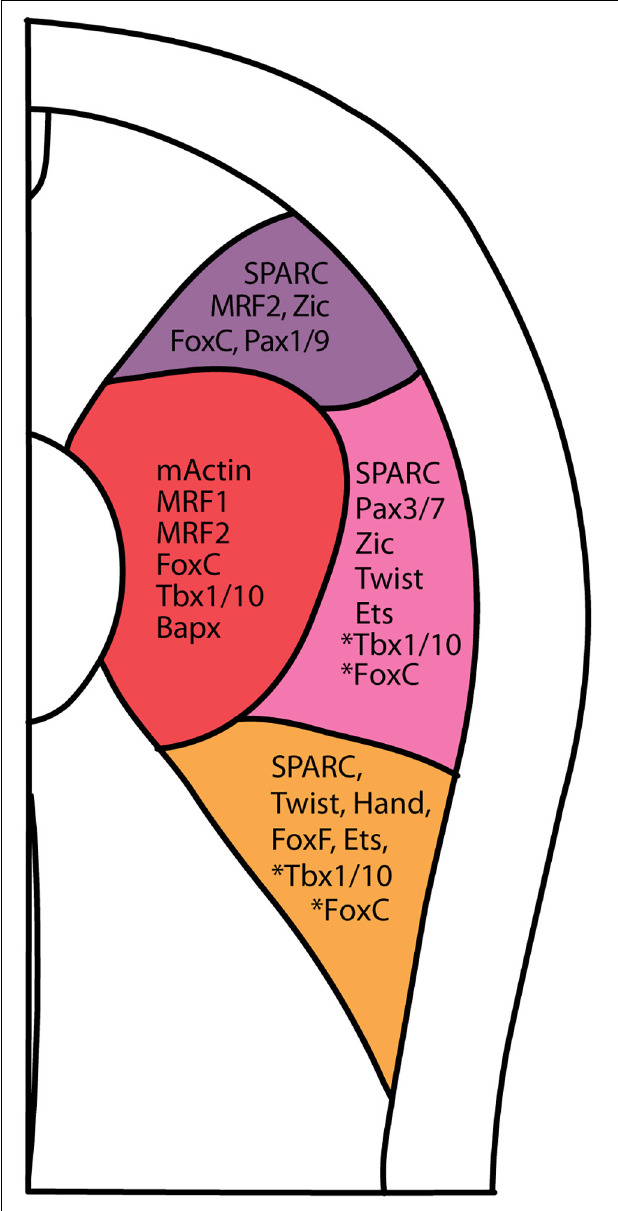
FIGURE 7 | Summary of vertebrate somite compartment markers in amphioxus at approximately 5th somite level of a N3 stage embryo. Asterisk next to Tbx1/10 and FoxC indicates that the presence of Tbx1/10 and FoxC in centro-lateral and ventro-lateral domain only in 1st somite pair ( FoxC ), and 2nd and 3rd pair somite ( Tbx1/10